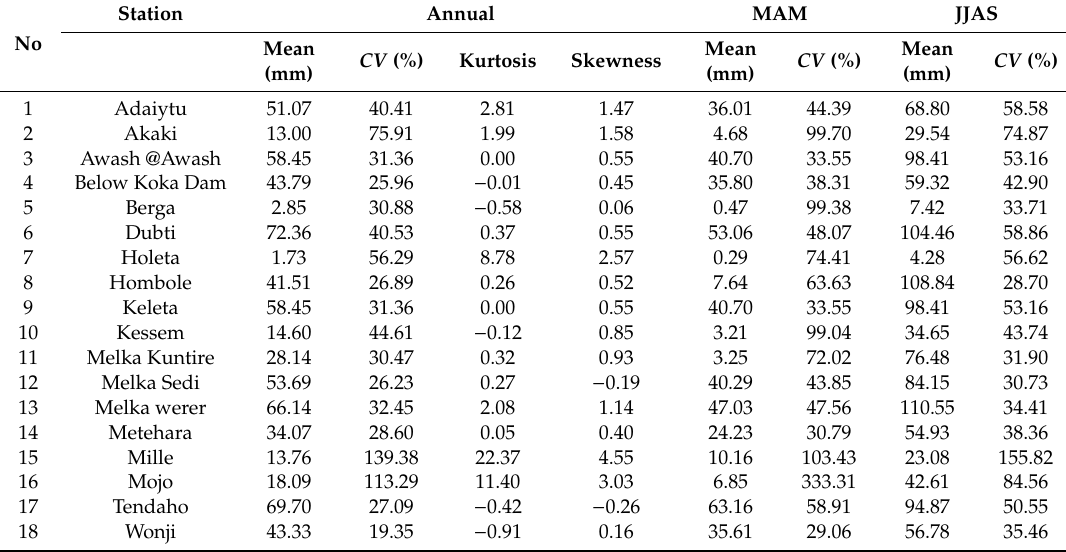
Table 2. Summary of descriptive statistics of streamflow in the ARB.